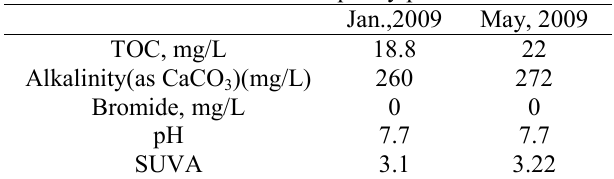
Table 2. Ground water quality